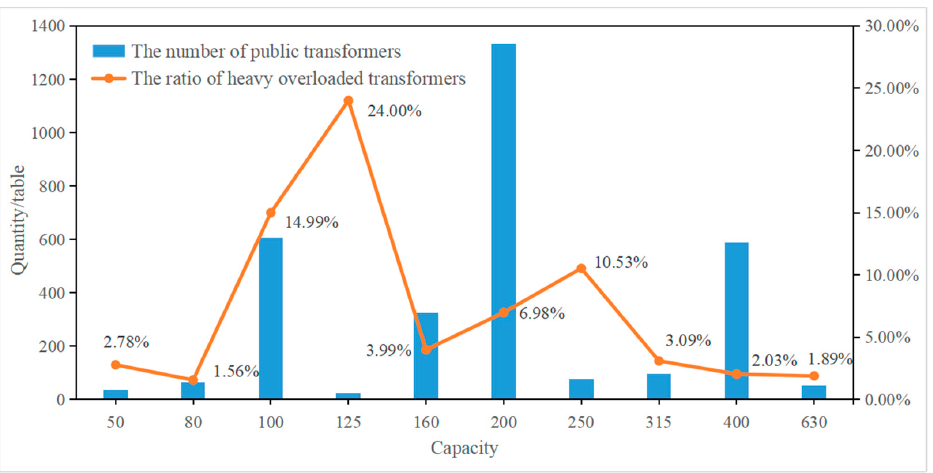
Figure 4. The ratio of the number of heavy overloads of public transformers counted by capacity in a specific period of a region.